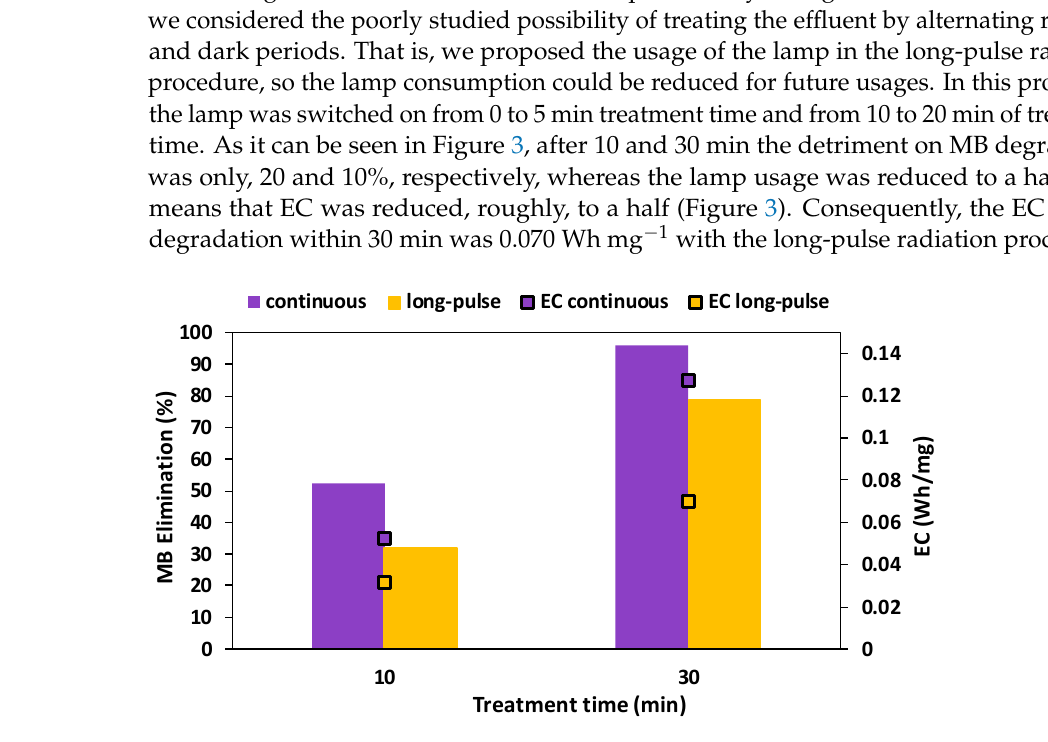
Table 1. Last reported data on MB and BPA UV-photocatalysis degradation.